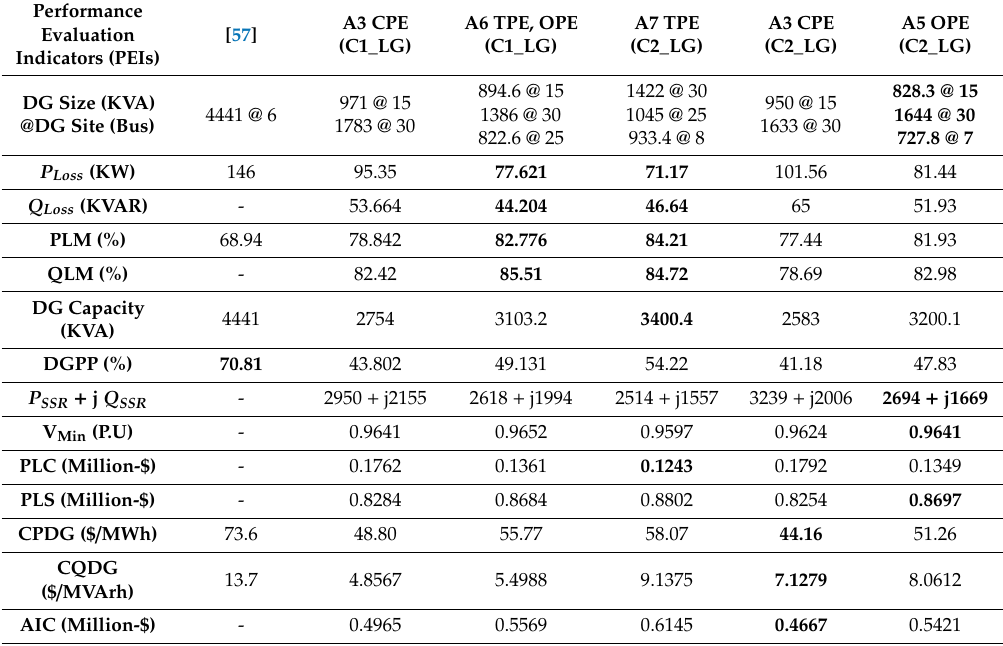
Table 34. Comparisons of results with C1_LG and C2_LG for 33-bus TDN (DG@LPF = 0.90, 0.85).